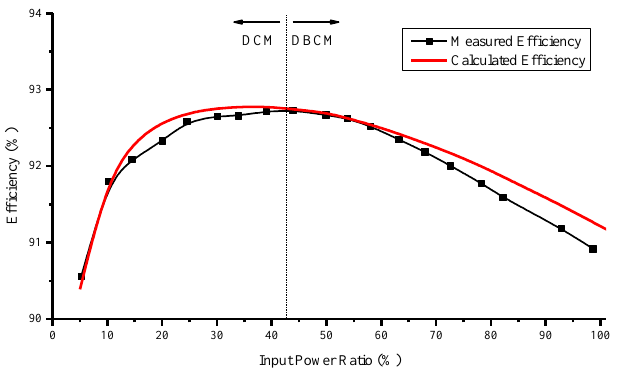
Figure 7. Calculated and measured efficiency versus power ratio for 0 °C ( P PV,max = 205 W, V dc = 40 V).